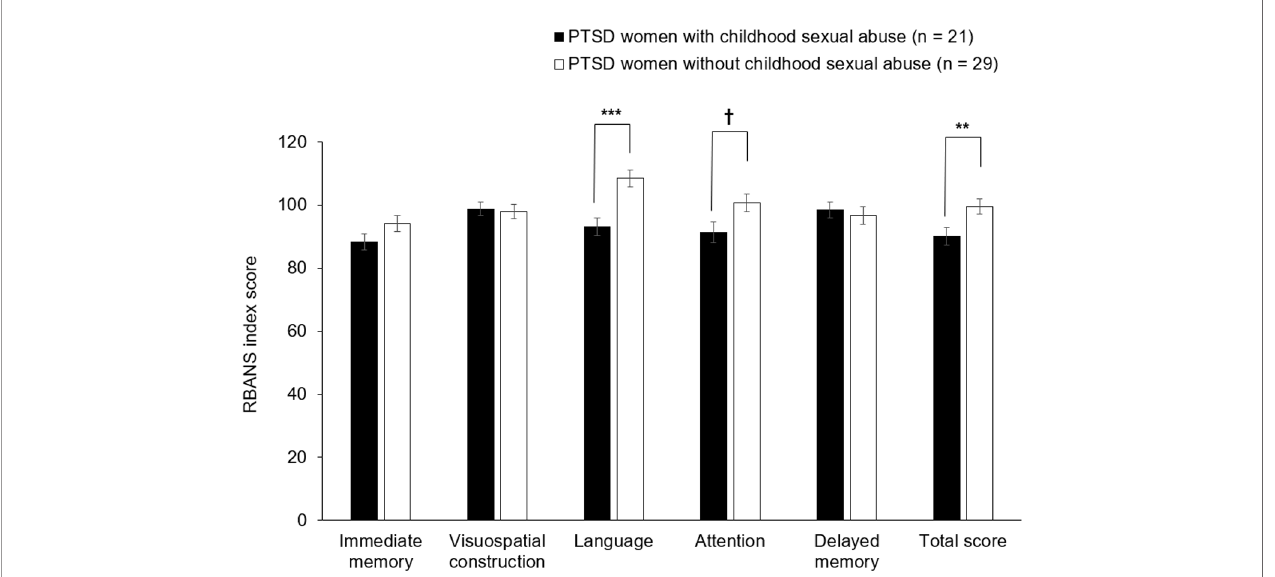
FIGURE 2 | Comparison of the RBANS scores between PTSD patients with and without history of childhood sexual abuse. PTSD patients with history of childhood sexual abuse (n = 21) were de fi ned as those patients whose CTQ sexual abuse scores were 6 or more; while PTSD patients without history of childhood sexual abuse (n = 29) were de fi ned as the remaining patients whose CTQ sexual abuse scores were less than 6. Comparisons were made by the post-hoc pairwise analysis of 2-way analysis of covariance. Error bars indicate SEM. † p = 0.037; **p = 0.011; ***p < 0.001. CTQ, Childhood Trauma Questionnaire; RBANS, Repeatable Battery for the Assessment of Neuropsychological